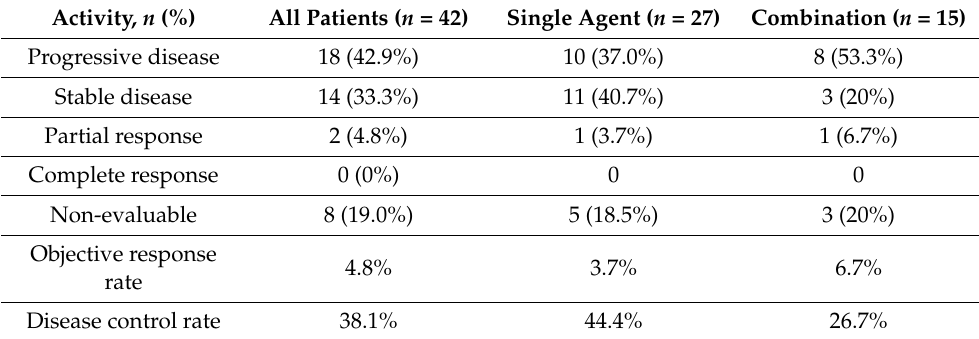
Table 2. Best objective response, all patients.